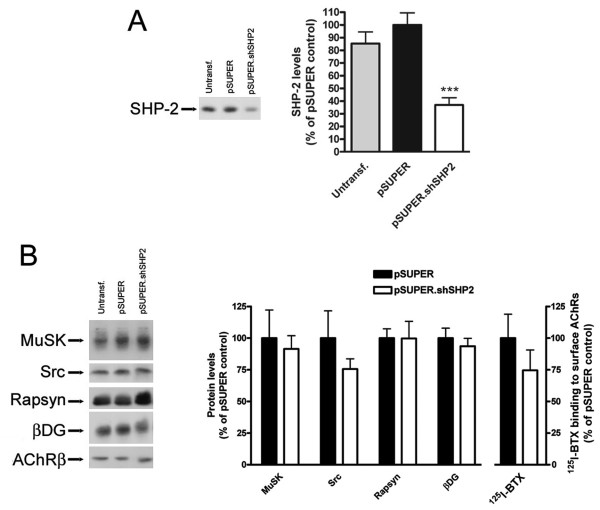
Gene-specific targeting of SHP-2 in C2C12 myotubes through vector-driven shRNA specifically knocks down SHP-2 protein. (A) C2C12 myotubes were transfected with pSUPER.shSHP2 construct targeting a specific region of the murine SHP-2 ORF. No transfection (Untransf.) or pSUPER vector only (pSUPER) transfected myotubes served as controls. Western blot analysis of SHP-2 levels revealed that pSUPER.shSHP2 knocked down > 60% of endogenous SHP-2. SHP-2 levels were quantitated by densitometric scanning and are shown as % of pSUPER vector only transfected myotubes (means ± SEM, from eight experiments). *** indicates a significant difference to the other bars (p < 0.0001; two-tailed unpaired t test). (B) The effect of SHP-2 gene targeting on levels of several postsynaptic proteins and functional surface AChRs was analyzed by pSUPER.shSHP2 transfection followed by Western blot analysis or radioligand binding assays (125I-α-BTX binding to intact C2C12 myotubes). This revealed that SHP-2 knockdown does not significantly influence the levels of MuSK, Src, rapsyn and β-dystroglycan. Protein levels were calculated and shown as % of respective pSUPER vector only transfected myotubes (means ± SEM, from eight experiments). Equal amounts of overall protein were loaded on the gels. Similarly, 125I-α-BTX binding to surface AChRs in intact C2C12 myotubes shows that following SHP-2 knockdown there is no significant effect on the surface levels of AChRs, when compared to radioligand binding on control transfected myotubes.